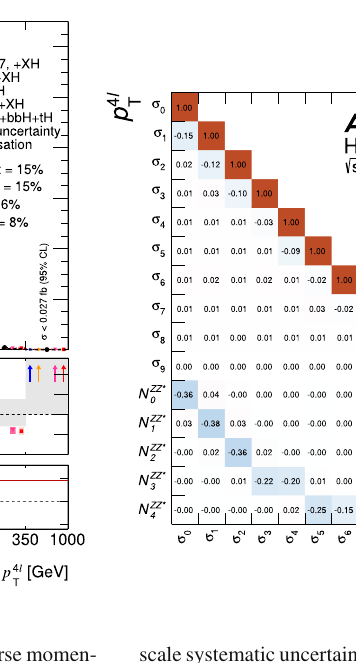
scale systematic uncertainties, calculated as described in Sect. 8.2. This includes the uncertainties related to the XH production modes. The p - values indicating the probability of compatibility of the measurement and the SM prediction are shown as well. They do not include the sys- tematic uncertainty in the theoretical predictions. The central panel of a showstheratioofdifferentpredictionstothedata,andthegreyarearep- resents the total uncertainty of the measurement. The bottom panel of a shows the ratios of the fitted values of the Z Z ∗ normalisation factors to the predictions from MC simulation discussed in Sect. 3. As indicated by the horizontal error bars, the Z Z ∗ normalisation is estimated in each of the first three p 4 (cid:3) bins separately, while the next two bins share a T common estimation factor, as do the last five